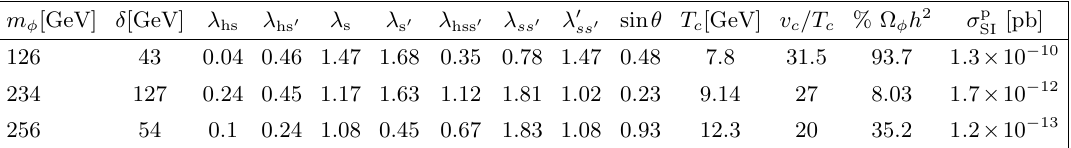
Table 2 . Benchmarks for scenario 2.2.1 in the model with the s - s 0 cross-coupling terms. m (cid:30) [GeV] (cid:14) [GeV] (cid:21) hs (cid:21) hs 0